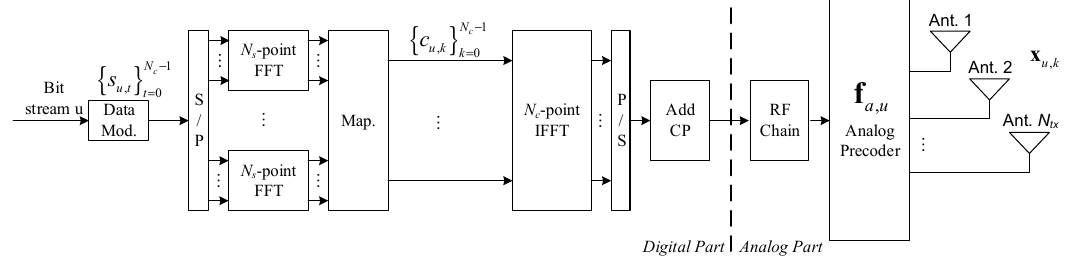
Figure 1. Schematic of the u th user terminal transmitter. CP is cycle prefix, RF is radio frequency, FFT and IFFT are the fast Fourier transform and inverse fast Fourier transform.